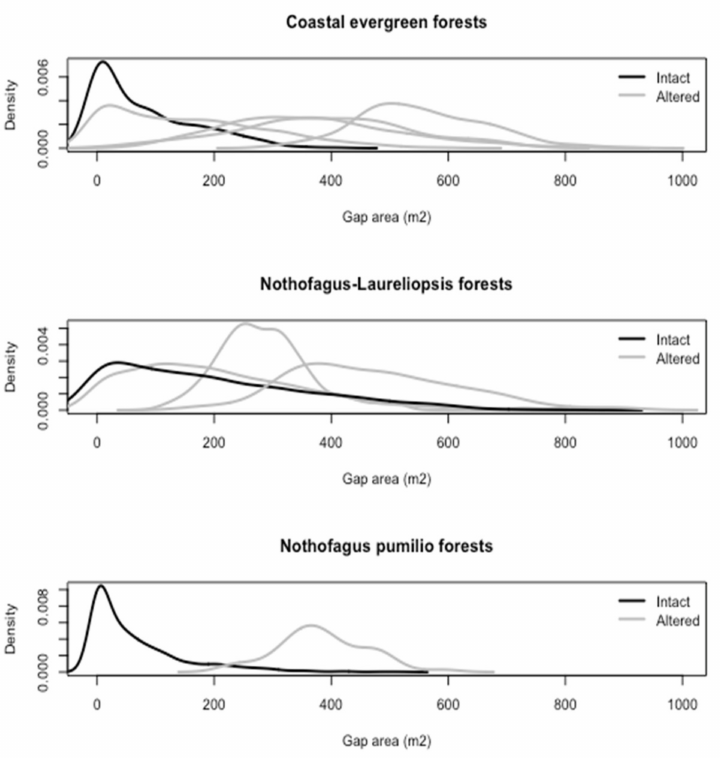
Figure 2. Comparison of the gap area frequency distributions in altered and intact forests.